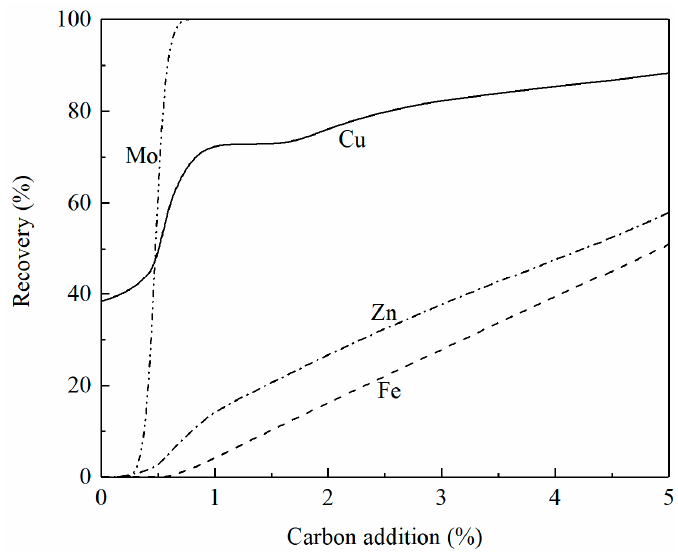
Figure 8. Effect of carbon addition on the recovery of copper, iron, zinc, and molybdenum from smelting slag at 1250 ° C, calculated by FactSage 8.2.